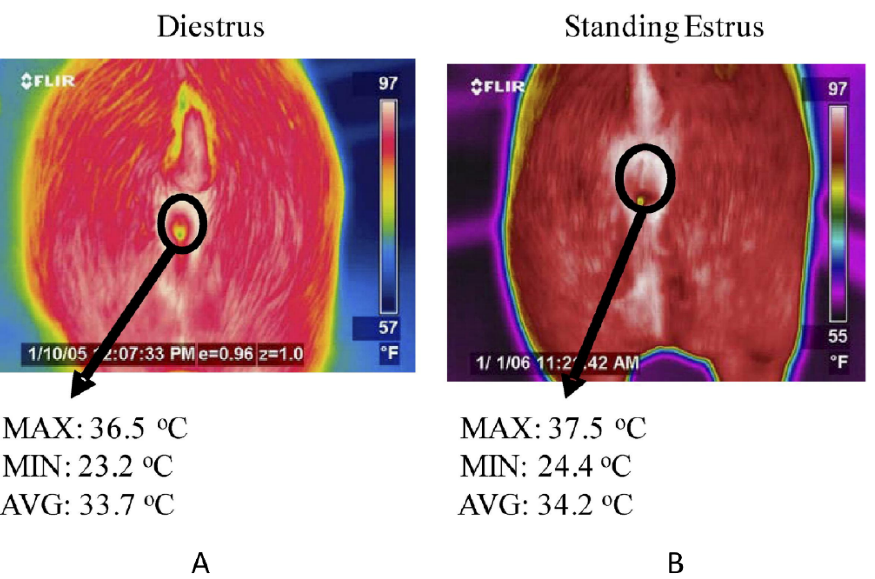
Figure 4. IRT imaging technology in early identification of estrus in animals. The region of interest from which vulva thermal measurements were determined in gilts is indicated by the circle and the maximum (MAX), minimum (MIN), and average (AVG) temperature values of representative gilts ( A ) in diestrus and ( B ) in standing estrus are shown for the thermal images above. Reprinted with permission from Ref. [90]. Copyright Elsevier and copyright clearance center.